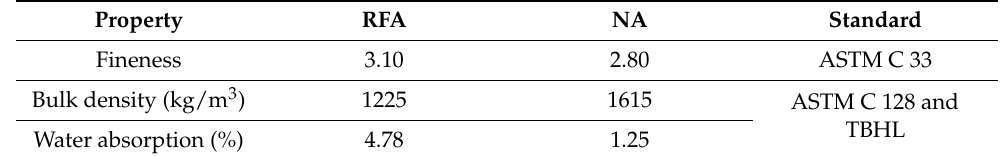
Table 1. Physical proprieties of RFA.